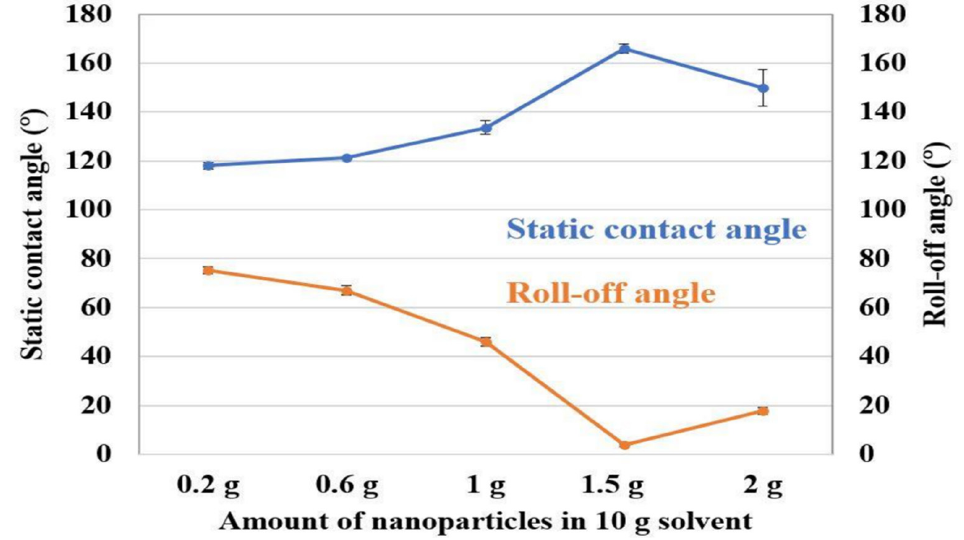
Figure 9. Static contact angle and roll off angle variation over different nanoparticle